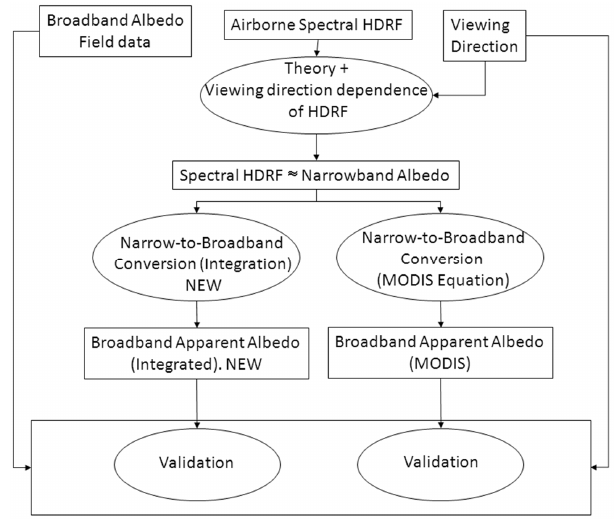
Figure 1. Flow chart of the two procedures for estimating the broadband apparent albedo.